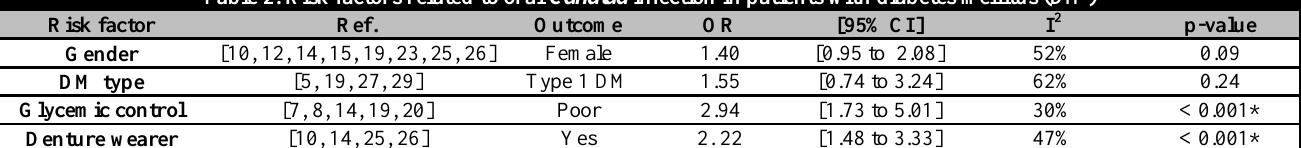
Table 2. Risk factors related to oral Candida infection in patients with diabetes mellitus (DM) Risk factor Ref.